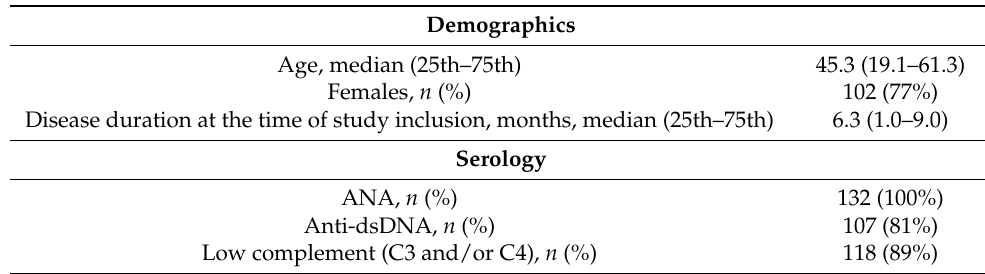
Table 1. Baseline characteristics of included patients. (ANA = antinuclear antibodies; anti- dsDNA = anti-double stranded DNA antibodies; aPL = antiphospholipid antibodies).